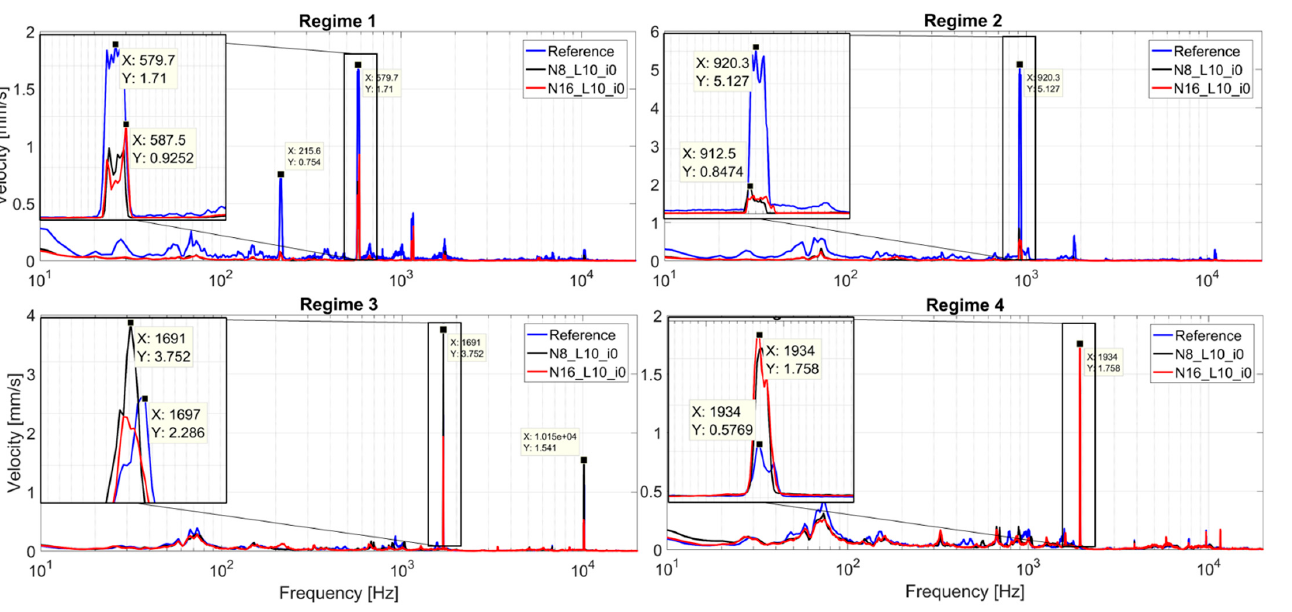
Figure 7. Spectral analysis of axial vibration for each regime and tested nozzle.